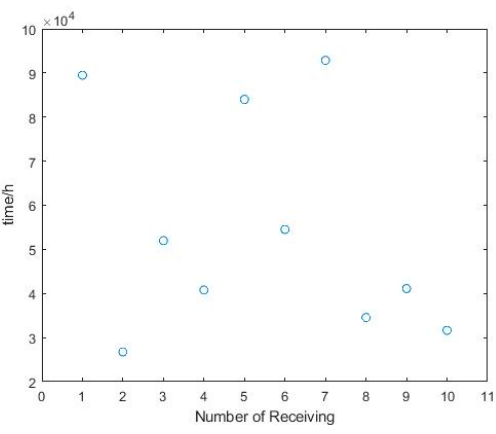
Figure 5. GPS receiver test data.